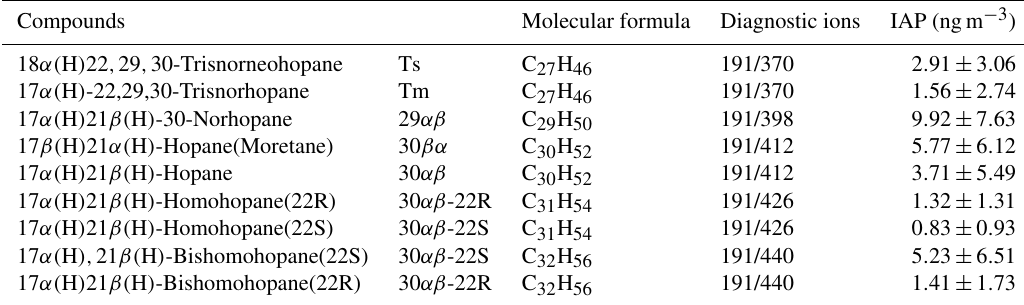
Table 2. Molecular formula, diagnostic ions and average concentrations of hopanes identified in PM 2 . 5 . Compounds Molecular